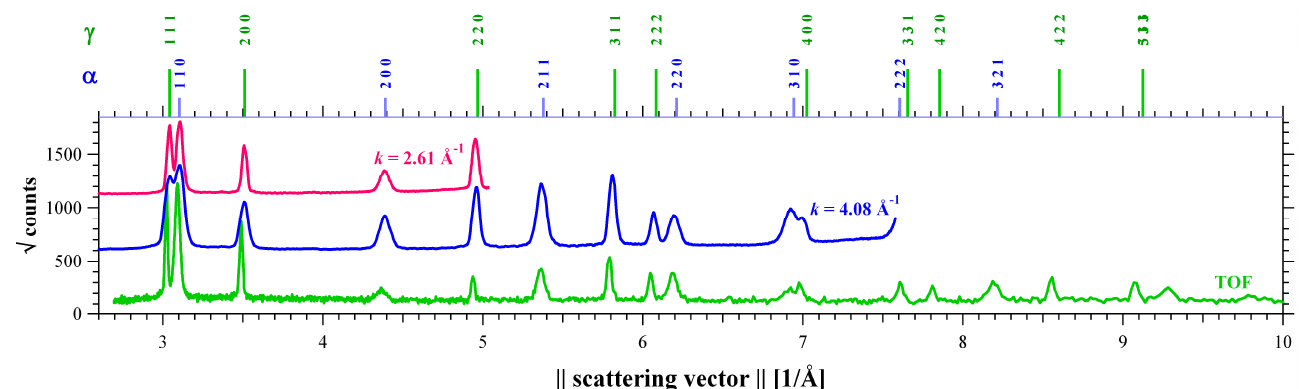
Figure 5. Neutron diffractograms integrated over all orientations for incident wavenumbers k 1 = 4.08 Å − 1 and k 2 = 2.61 Å − 1 , together with time-of-flight data acquired data at TAKUMI for comparison of instrumental resolution. The intensity scale of each neutron diffractogram was simply normalized according to its 110 reflection of martensite layers in the referred steel for easy comparison of peak